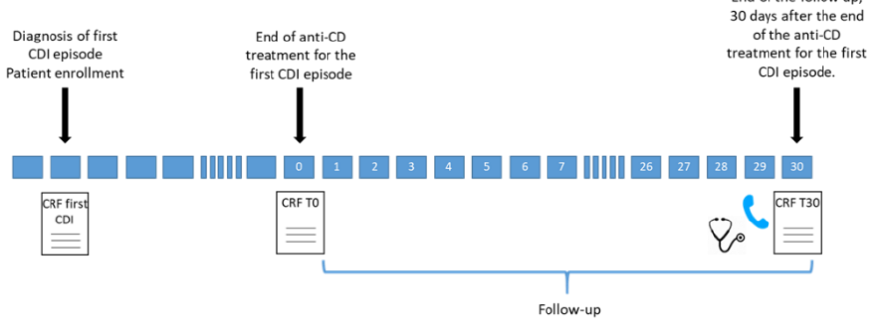
Figure 2. Details of the study follow-up. CDI: Clostridioides difficile infection. CRF: case report form.